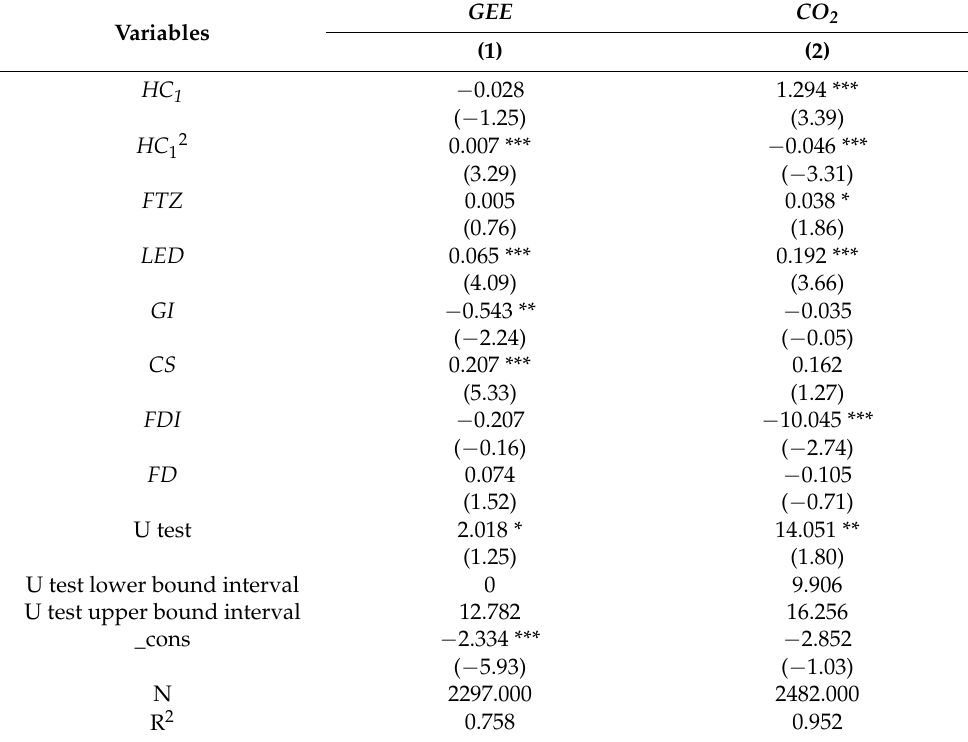
Table 6. Robustness test of the U-shaped relationship between human capital and GEE